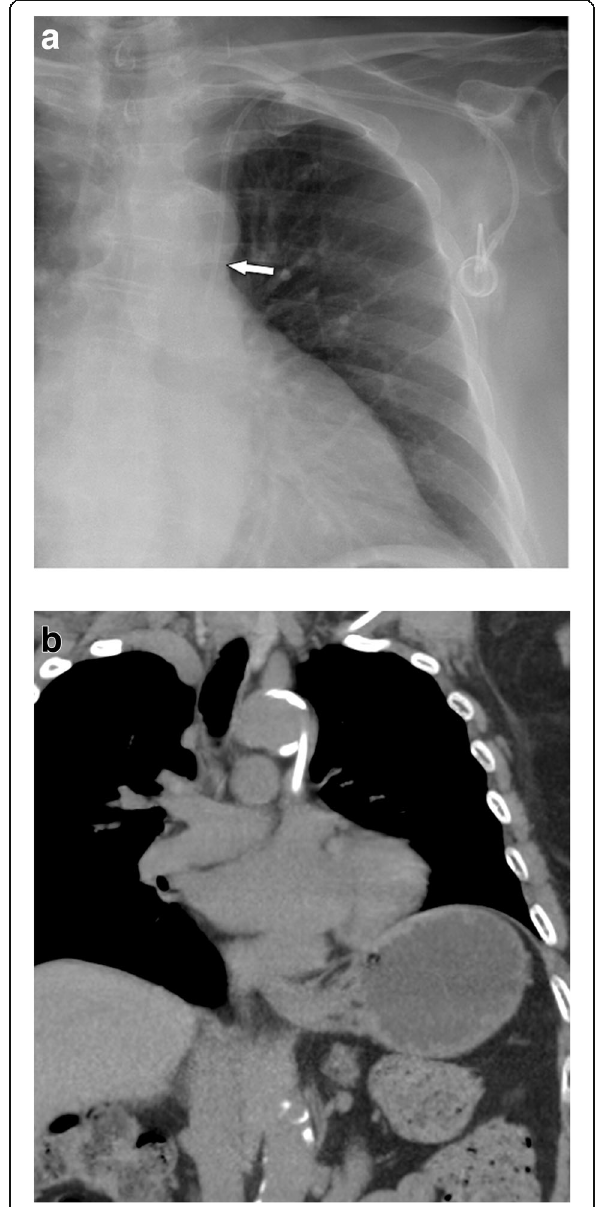
Fig. 3 a Malpositioning in a persistent left superior vena cava: on a chest film, this could be confused with arterial malpositioning in the aortic arch via the left subclavian artery. b Unenhanced CT shows the tip of the catheter in the SVC, which drains into the right